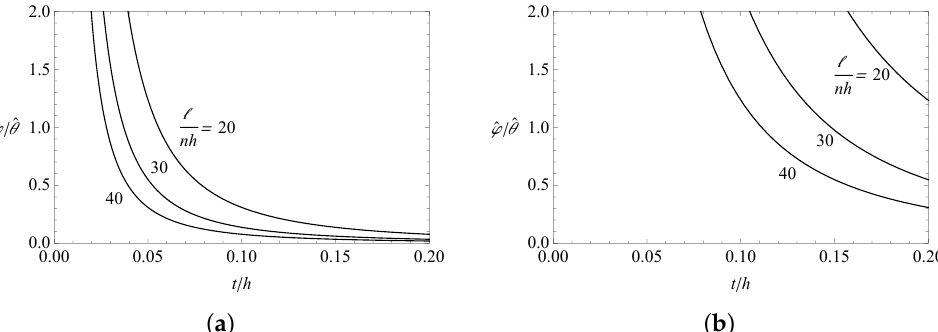
Figure 11. Distortion-to-twist ratio vs. the thickness-to-height ratio for different slenderness ratios (cid:96) b = h ; ( b ) rectangular box b